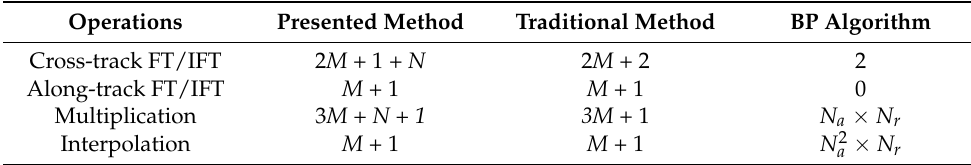
Table 4. Basic operations used by three imaging